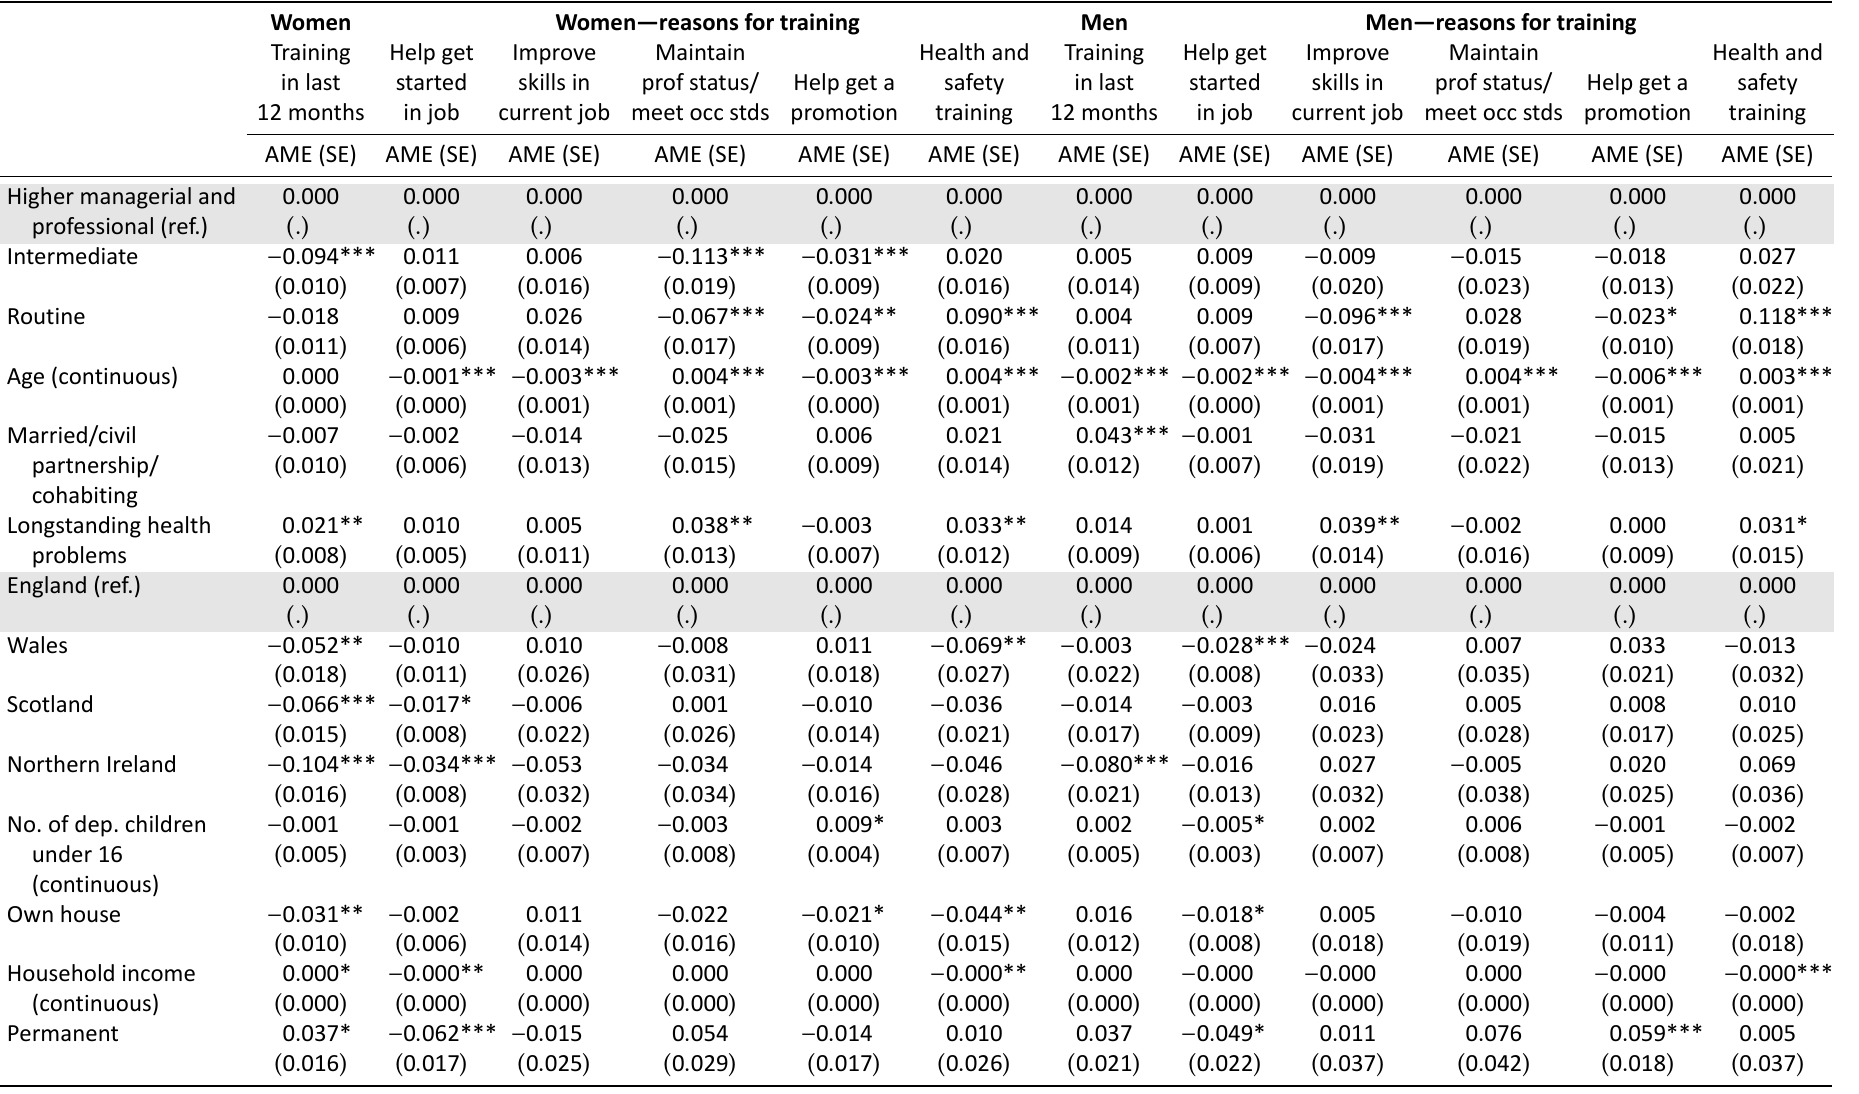
Table A4. Regression results, probability of participation in training in last 12 months, overall and by reason for training, men and women, pooled